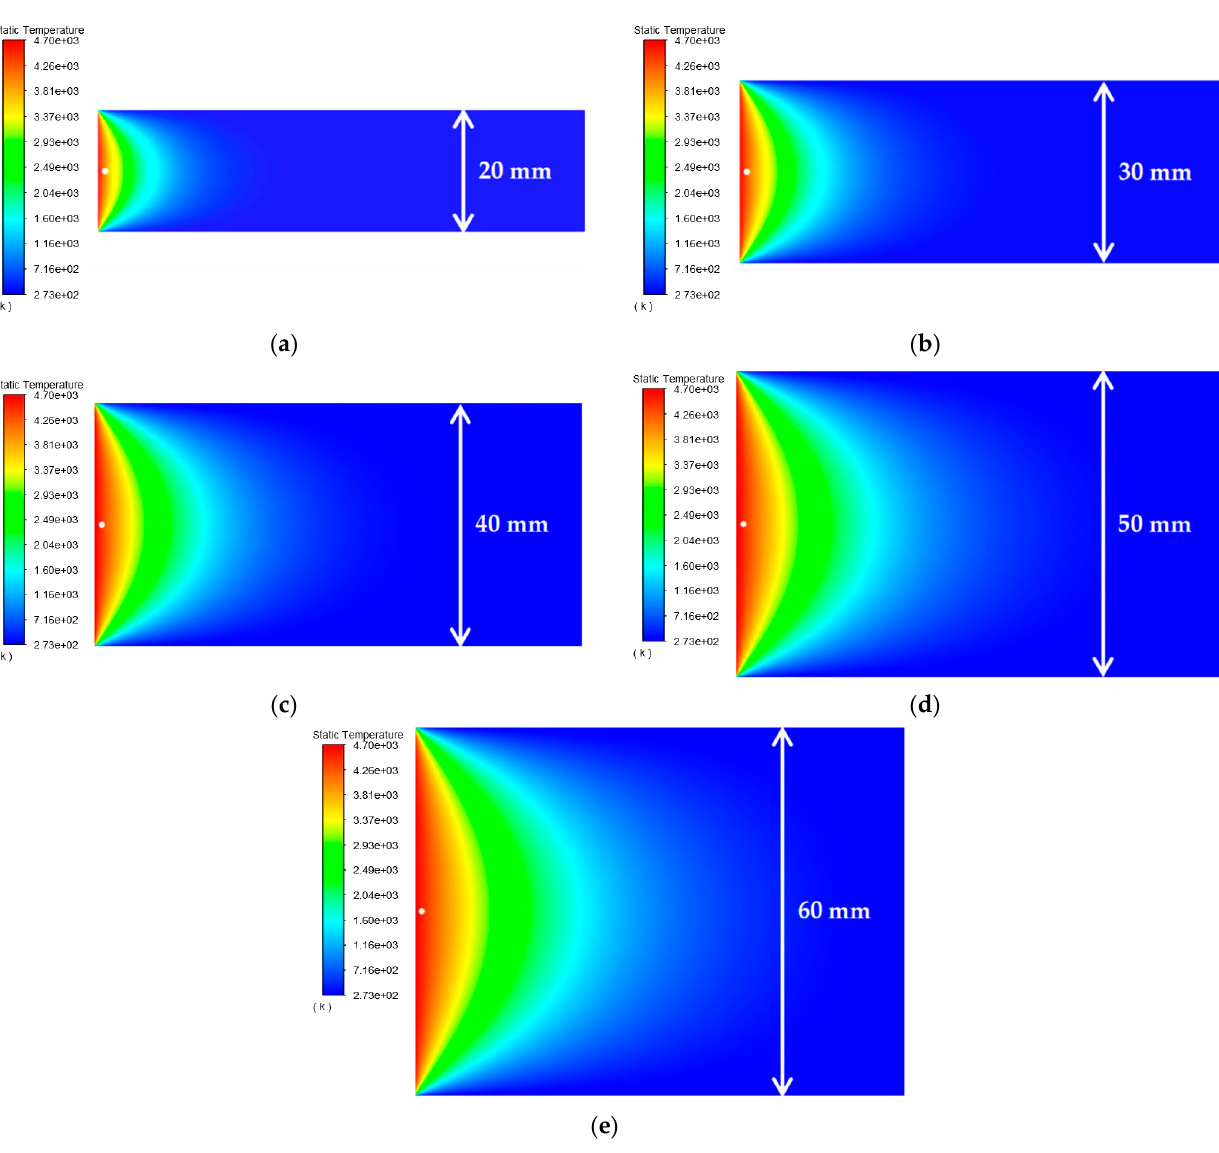
11 of 22 Figure 3. Schematic diagram of two-dimensional pulse heating. The temperature amplitude of the incident heat wave is then given as 1300 °C, then the position of the circular through hole and the parameters of the incident light source are changed, and the temperature distribution results are obtained by the above-men- tioned temperature distribution expression. At the same time, the corresponding thermal simulation analysis is carried out by ANSYS, and the two analysis results are compared to verify the rationality of the semi-infinite slab structure model constructed in this paper